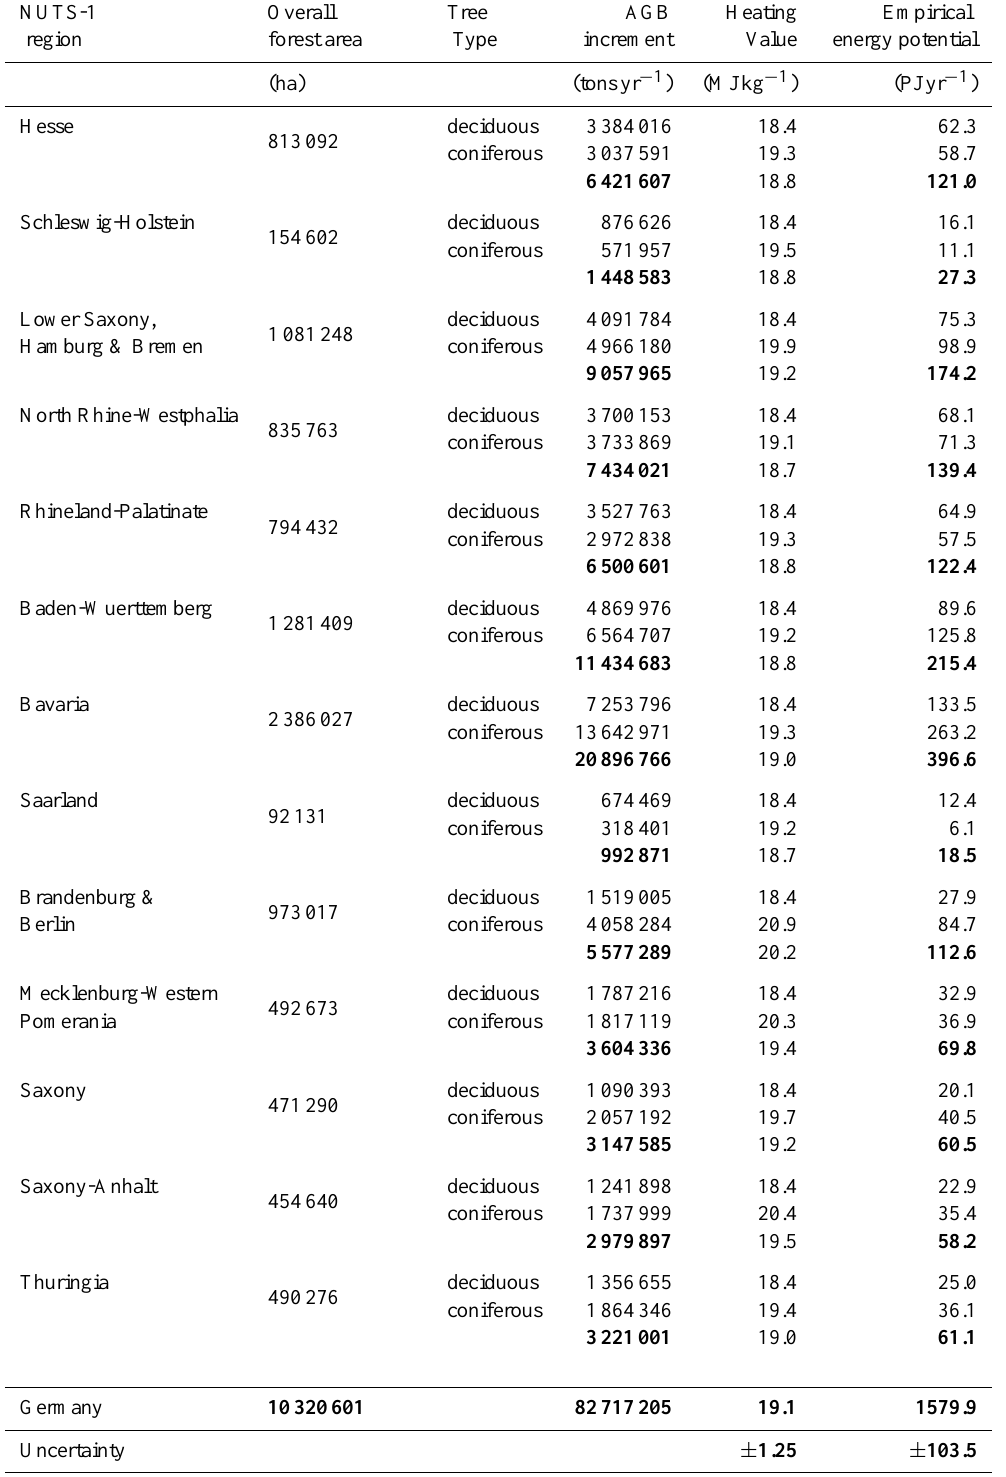
Table 5. Total forest areas, estimated increment of above-ground biomass from NFI data, heating values, and empirical energy potentials of woody biomass for Germany’s NUTS-1 regions, partitioned into deciduous and coniferous tree